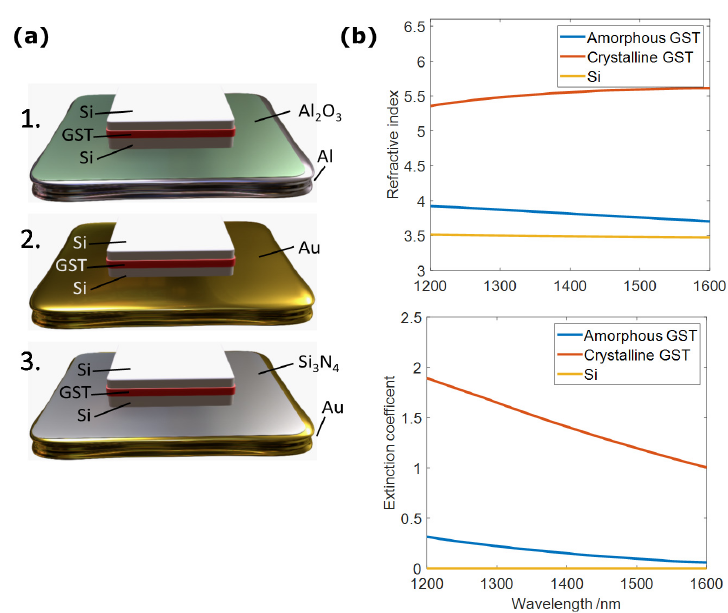
Figure 2. ( a ) Schematics of 3 unit cells (meta-atoms) explored in this work showing Si–GST–Si cubic resonators and different considered bottom planes. ( top ) Al with native Al 2 O 3 layer, ( middle ) Au, and ( bottom ) Au with an added Si 3 N 4 layer. These unit cells were repeated in a square lattice arrangement. ( b ) Refractive index and extinction coefficient of GST in amorphous and crystalline phases (measured via ellipsometry), and of silicon (taken from [33]) across spectral range of inter- est.